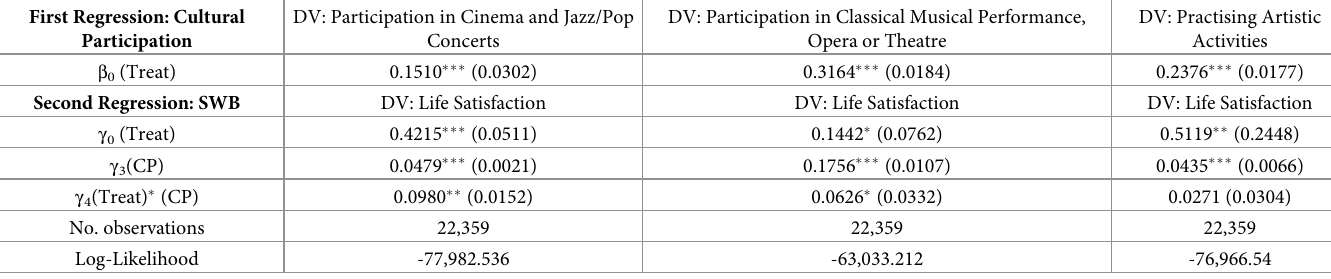
Table 10. Ordered Probit SURE